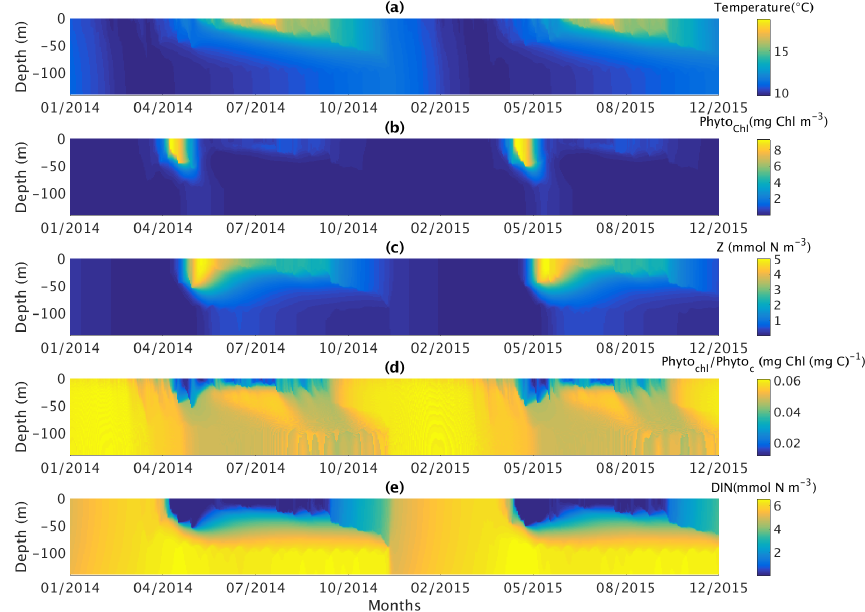
Figure 5. Observations from the cruises CD173 and JR98 for (a) chlorophyll a specific maximum light-saturated photosynthesis rate in different locations in the Celtic Sea and for the calibrated S2P3-Photoacclim model (cyan lines) and the S2P3 v8.0 model (green lines); (b) observations of the light saturation parameter ( E k ) for different stations across the Celtic Sea and for the calibrated S2P3-Photoacclim model (cyan lines) and the S2P3 v8.0 model (green lines). The data from both models were plotted for the same days that the observations were collected.